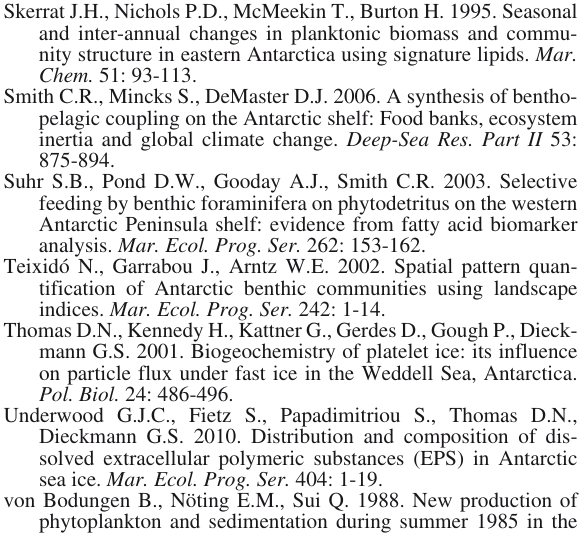
Number of analysed filters per depth and